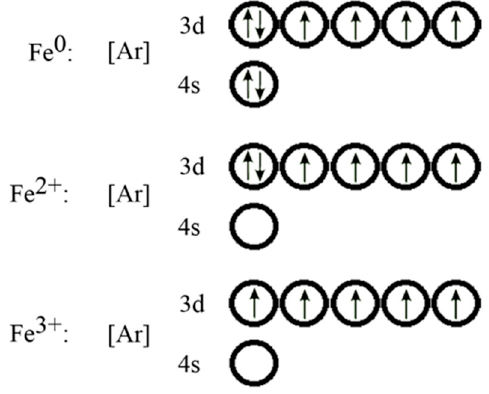
Figure 1. Orbital diagram for iron and iron ions.